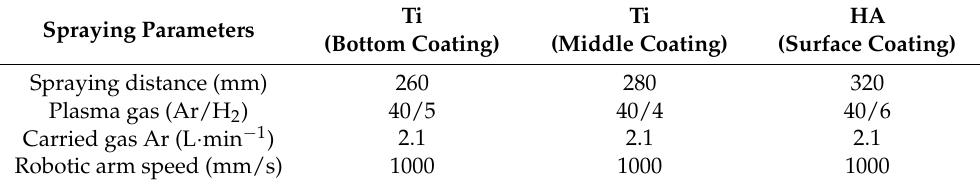
Table 1. Plasma spraying coating